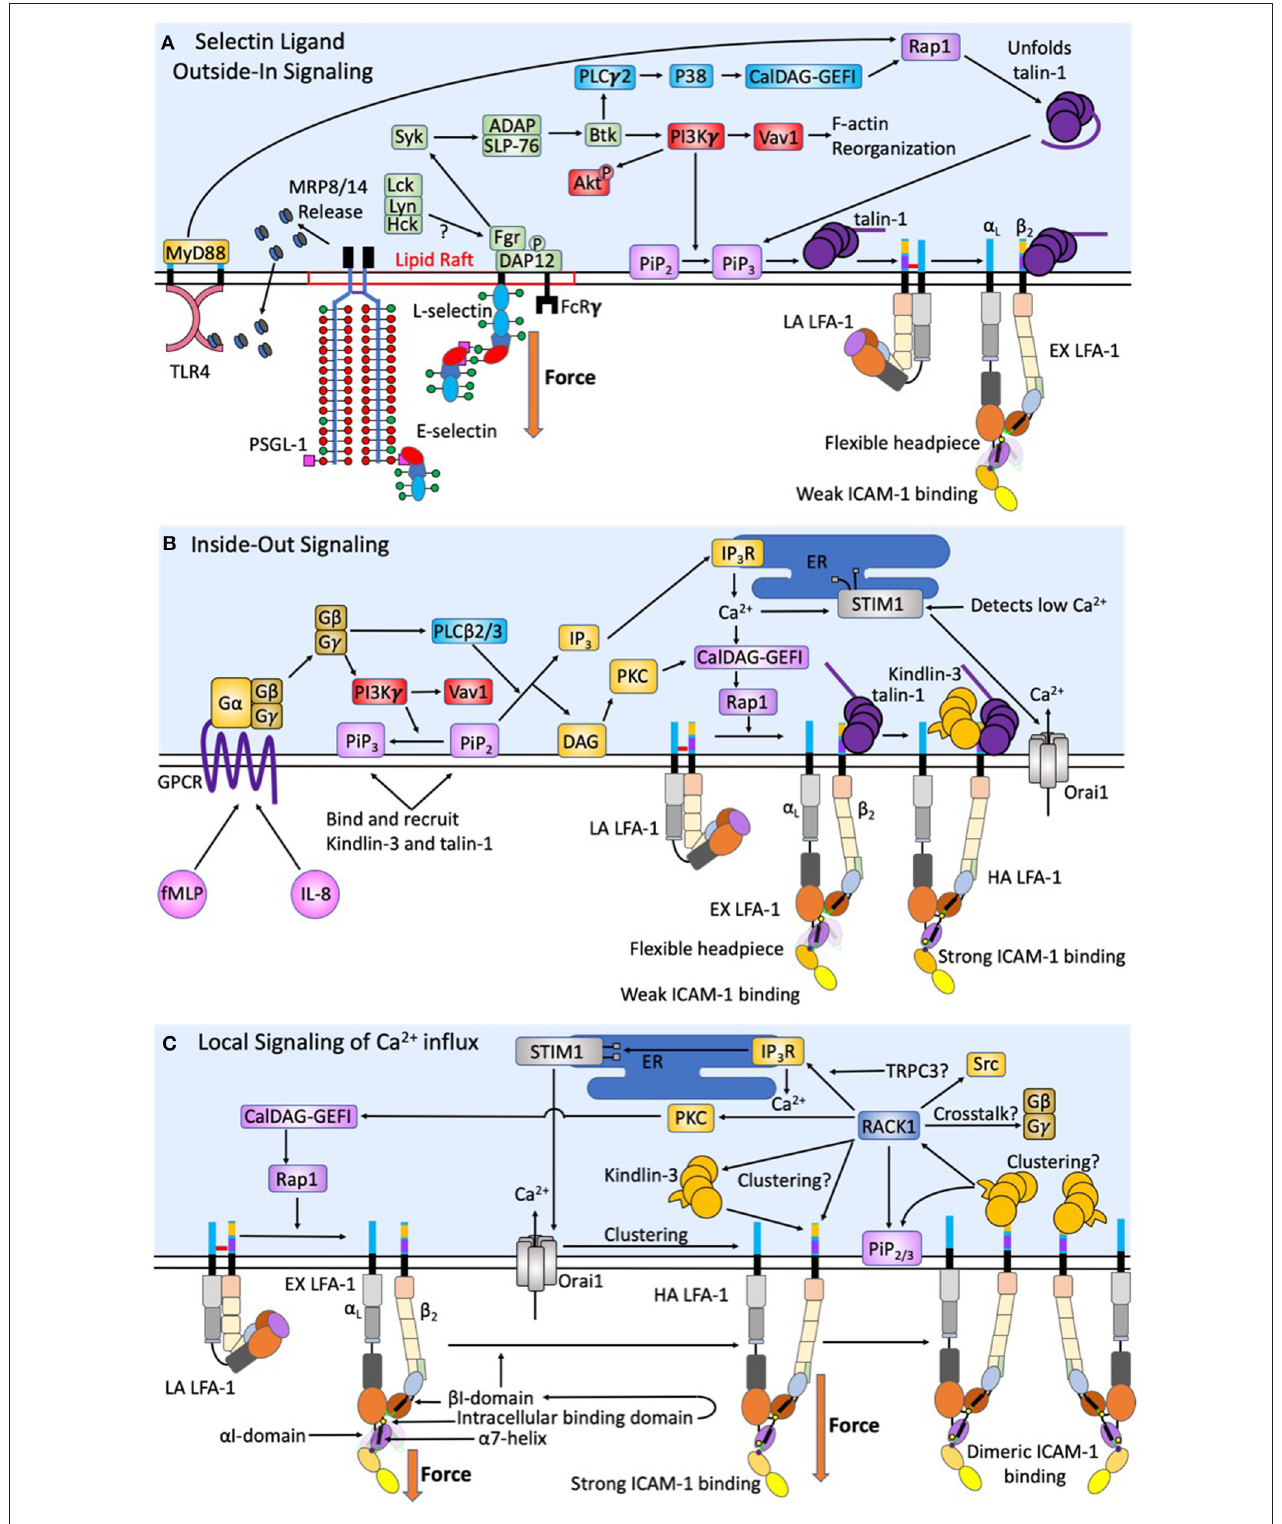
FIGURE 2 | Intracellular signaling events act synergistically to promote human neutrophil arrest and shape change. During initial capture and rolling on inflamed endothelium a low baseline level of intracellular calcium is maintained. (A) Force acting on L-selectin and PSGL-1 induces clustering and recruitment of FcR γ and